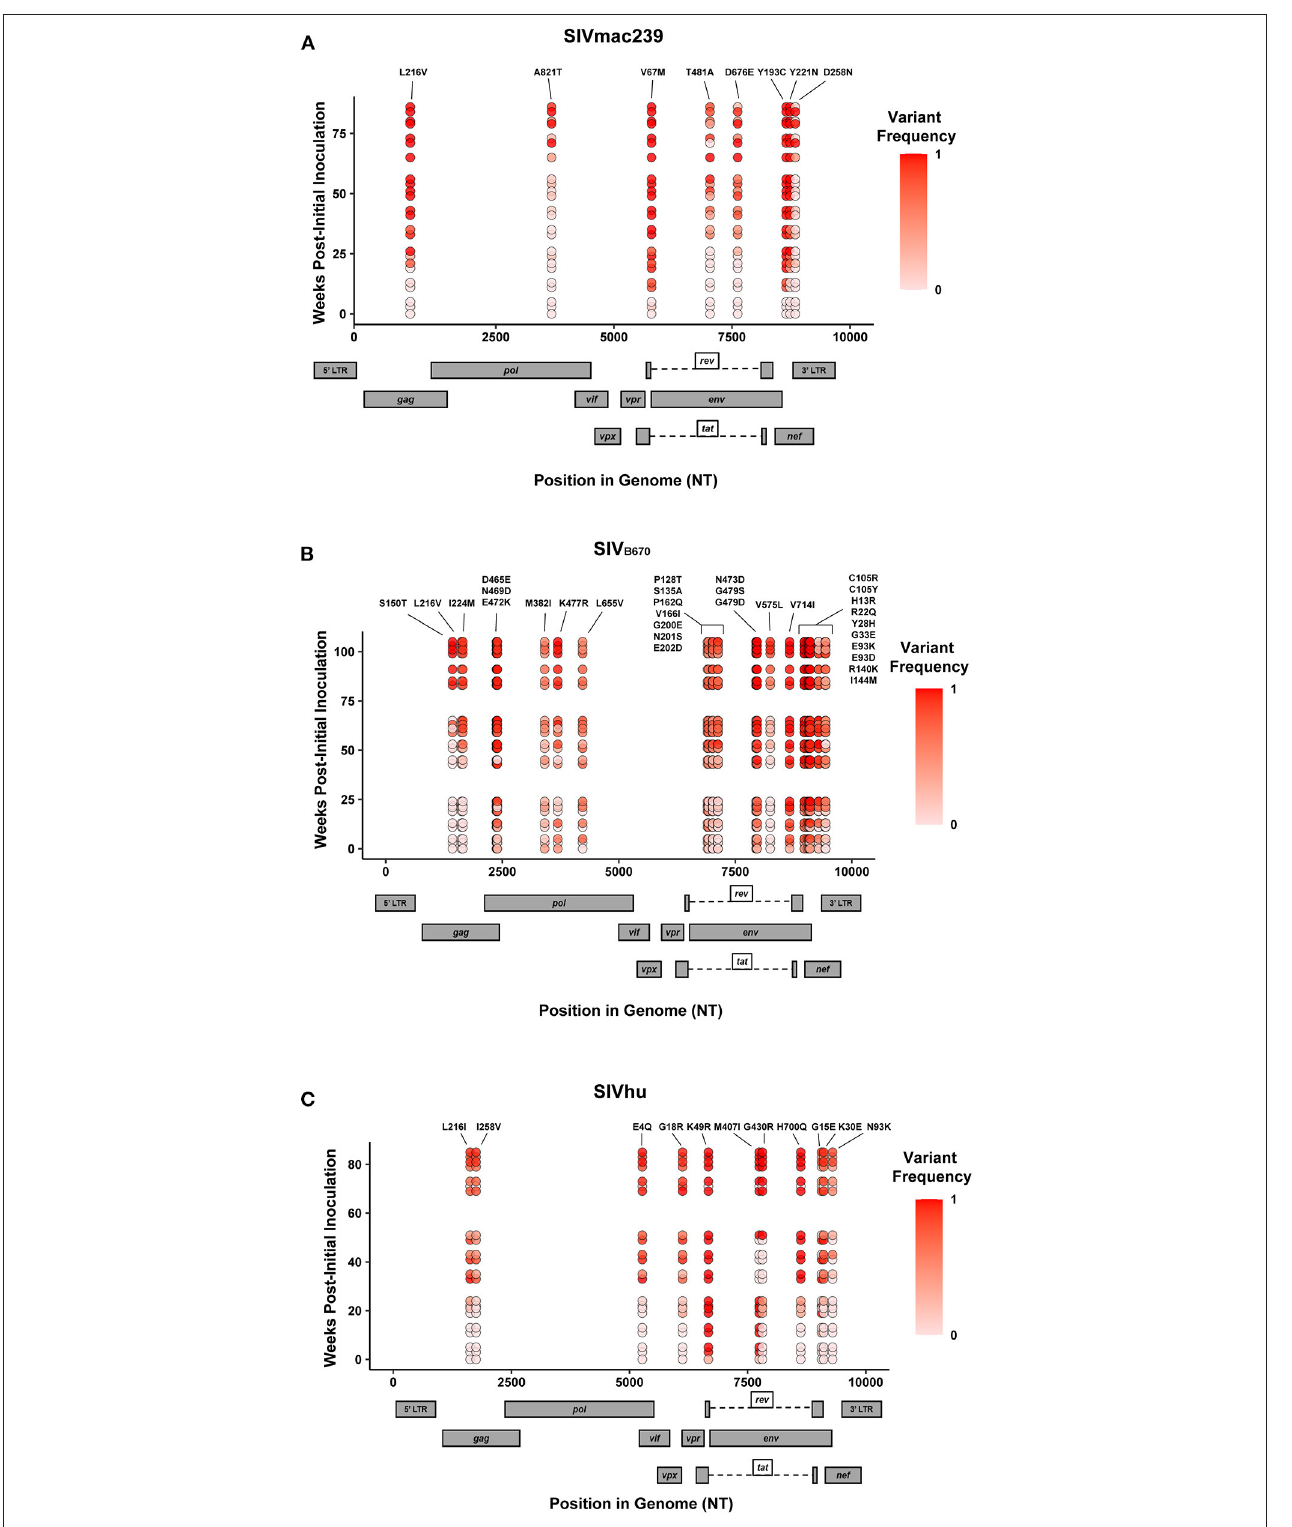
FIGURE 3 | Single nucleotide polymorphisms showing an increase in population frequency over three serial passages. Viral RNAs isolated from two infected hu-mice per viral strain per generation at early, middle, and late timepoints were sequenced. The non-synonymous mutations identified were present in the CDS, had an